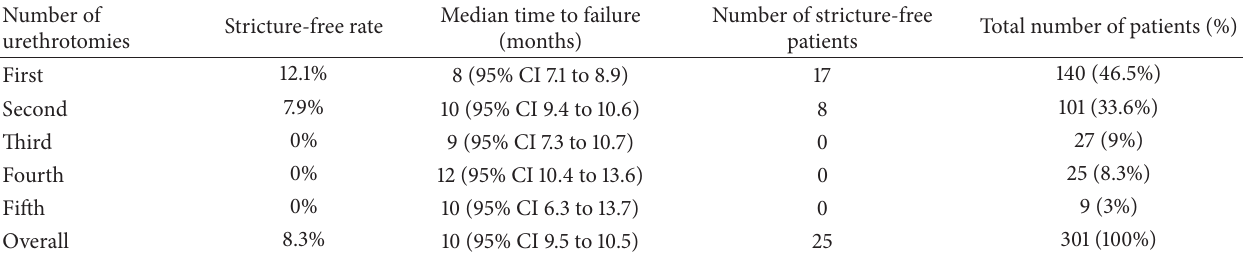
Table 2: Urethrotomy and stricture-free